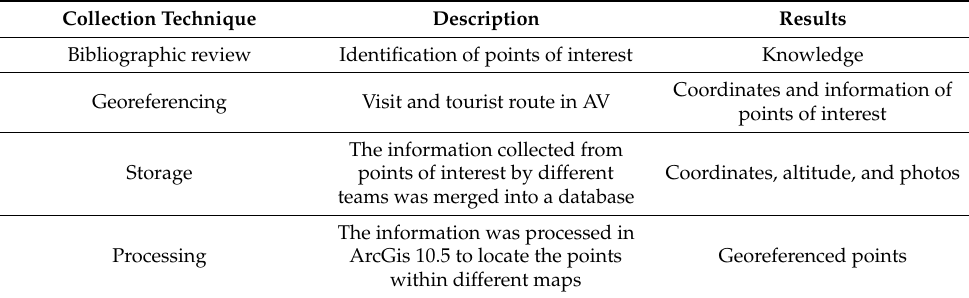
Table 1. Methodological steps used to collect data for the points of